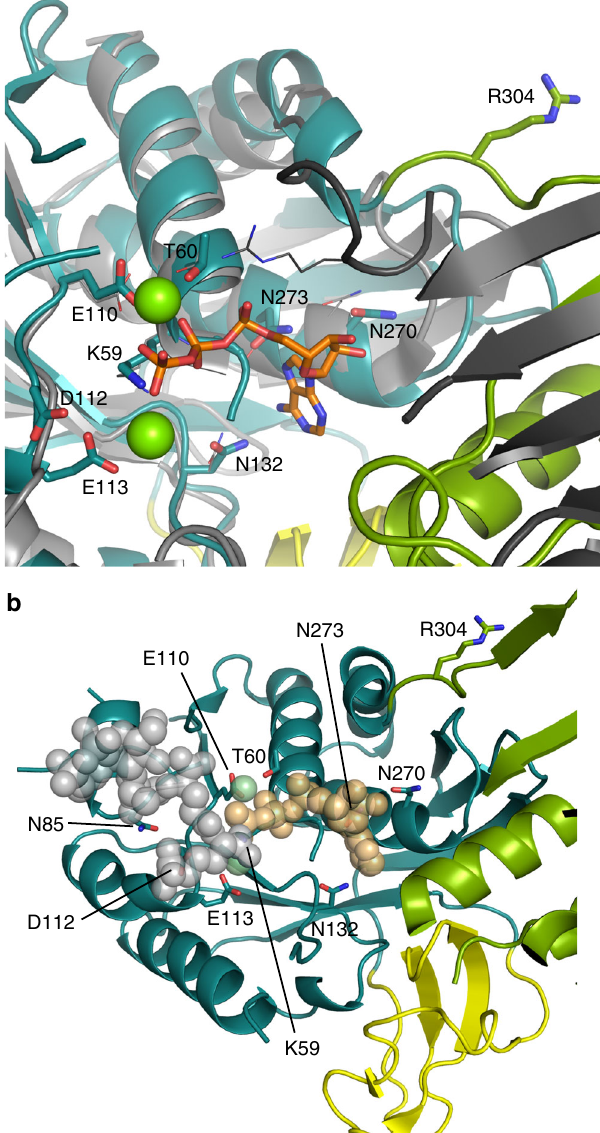
Fig. 5 The active site of MurT. a Superimposition of the active sites of MurT from S. pneumoniae and MurF from Acinetobacter baumannii (PDB# 4QF5, ATP-bound form of MurF). The central domains of MurT and MurF are colored in dark cyan and light grey, respectively. The C-terminal domains of MurT and MurF are colored in green and dark grey, respectively. The bound ATP in MurF active site is shown as atom-colored sticks and Mg 2 + ions as green spheres. b Ribbon representation of MurT active site with putative positioning of ATP, Mg 2 + , and Mur N ac tripeptide inferred from substrate- bound forms of MurF (PDB# 4QF5 and 4CVK). The ATP, Mg 2 + , and the Mur N ac tripeptide are shown as orange, green and grey spheres, respectively. MurT residues predicted to interact with the substrates are labeled and shown as atom-colored